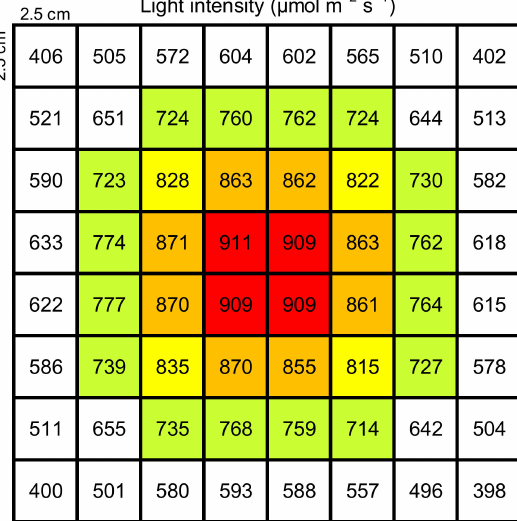
Figure 1. Distribution of photosynthetic photon flux density (PPFD, µ mol m − 2 s − 1 ) at the base of water bath tank during exposure to an LED light source. (Red-filled cells stand for PPFD larger than 900 µ mol m − 2 s − 1 ; orange-filled cells stand for PPFD ranged from 850 to 900 µ mol m − 2 s − 1 ; yellow- filled cells stand for PPFD ranged from 800 to 850 µ mol m − 2 s − 1 ; green-filled cells stand for PPFD ranged from 700 to 800 µ mol m − 2 s − 1 ; white-filled cells stand for PPFD less than 700 µ mol m − 2 s − 1